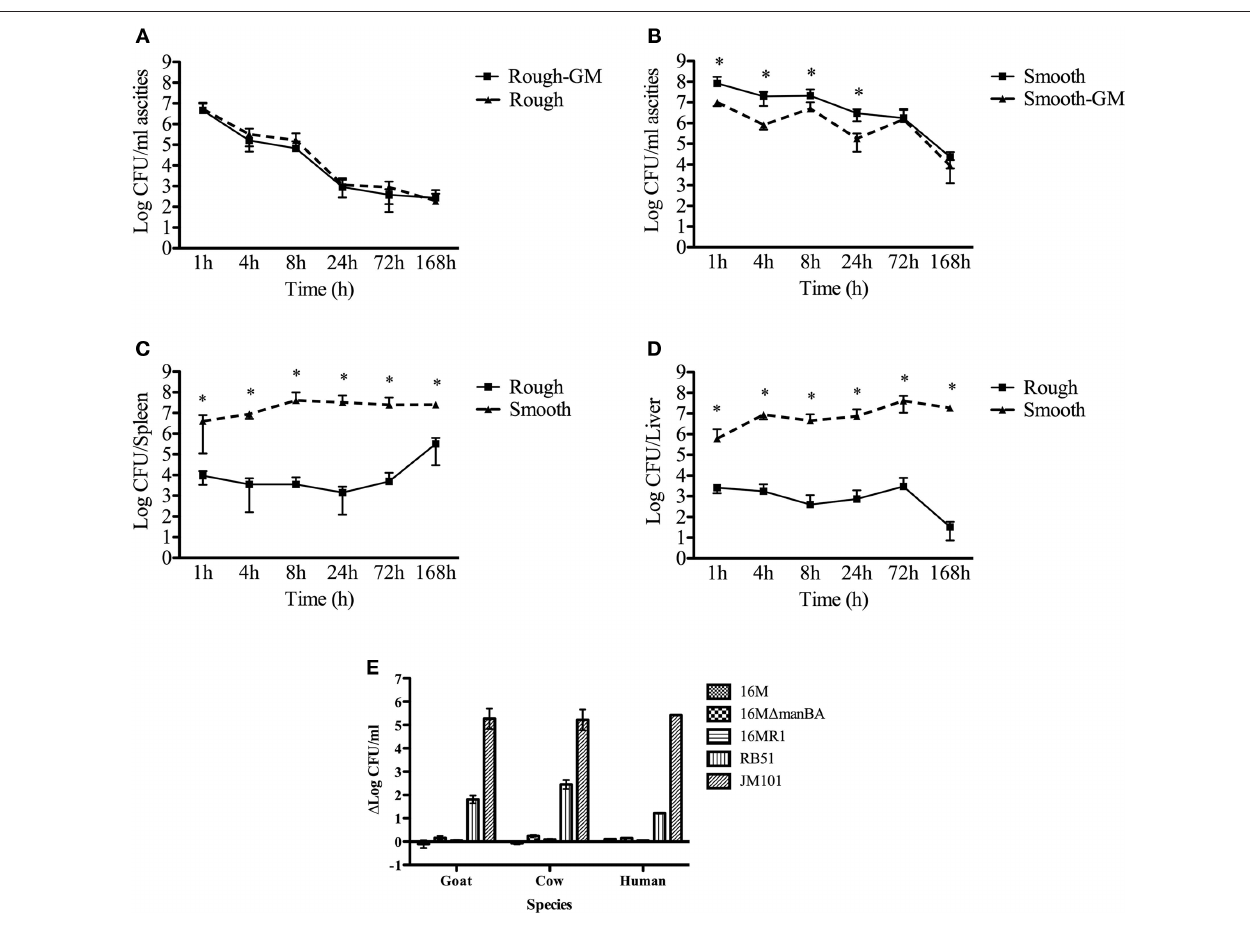
FiguRE 4 | Clearance kinetics of smooth and rough Brucella from the murine peritoneal cavity and in vitro susceptibility to complement. Mice were infected with 10 8 cfu of either smooth B. melitensis 16M or rough B. melitensis 16M ∆ manBA. Bacterial recovery from the ascites over a 7-day period revealed a lower percentage of smooth organisms (a) than rough organisms (B) internalized. Systemic infection was determined by recovery of smooth and rough organisms from secondary lymphoid organs, spleen (C) , and liver (d) . Significant differences ( p ≤ 0.05) are represented with asterisks (*).